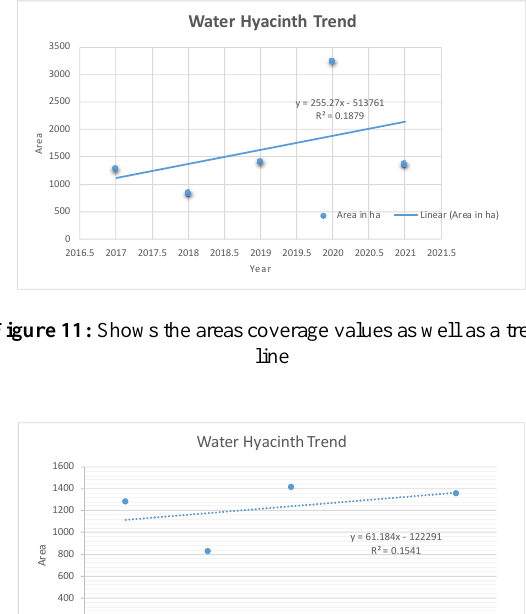
y = 61 . 184 x - 122291 R ² = 0 . 1541